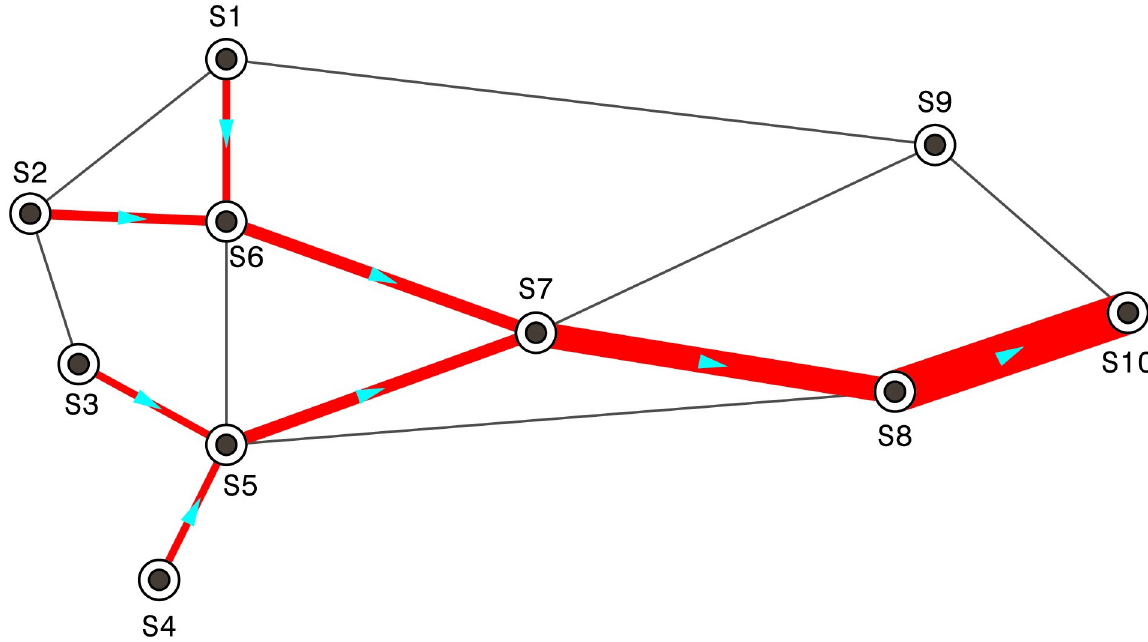
Fig 2. The tree-shaped